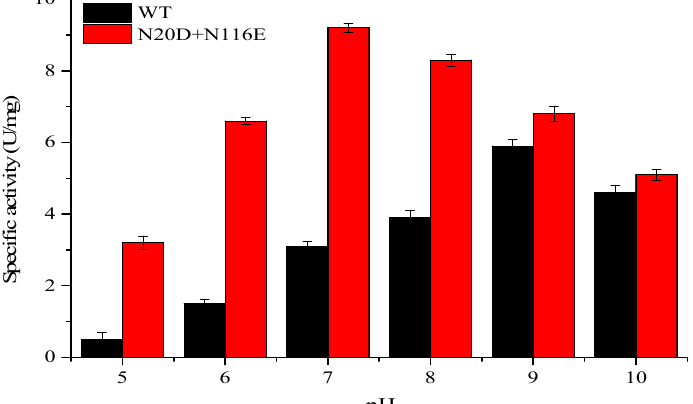
Figure 5. Effects of pH on the activities of WT and double mutant N20D/N116E.